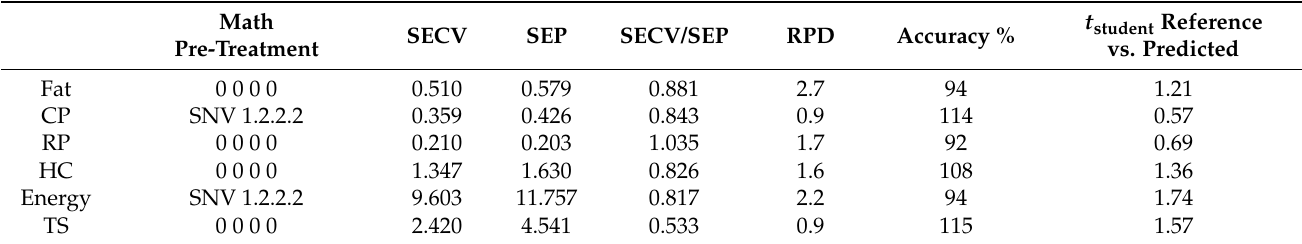
Table 3. External validation statistics used for predicting nutritive parameters of breast milk (valida- tion set, N =